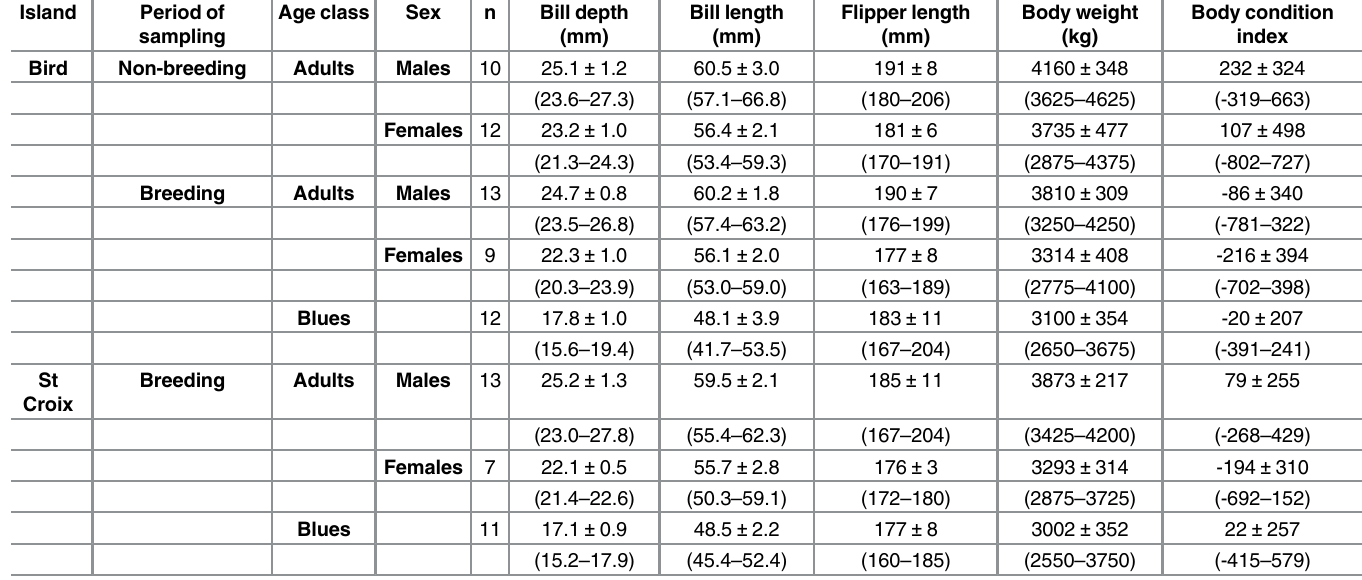
Table 1. Biological characteristics of the African penguins sampled on Bird and St Croix islands in 2013.